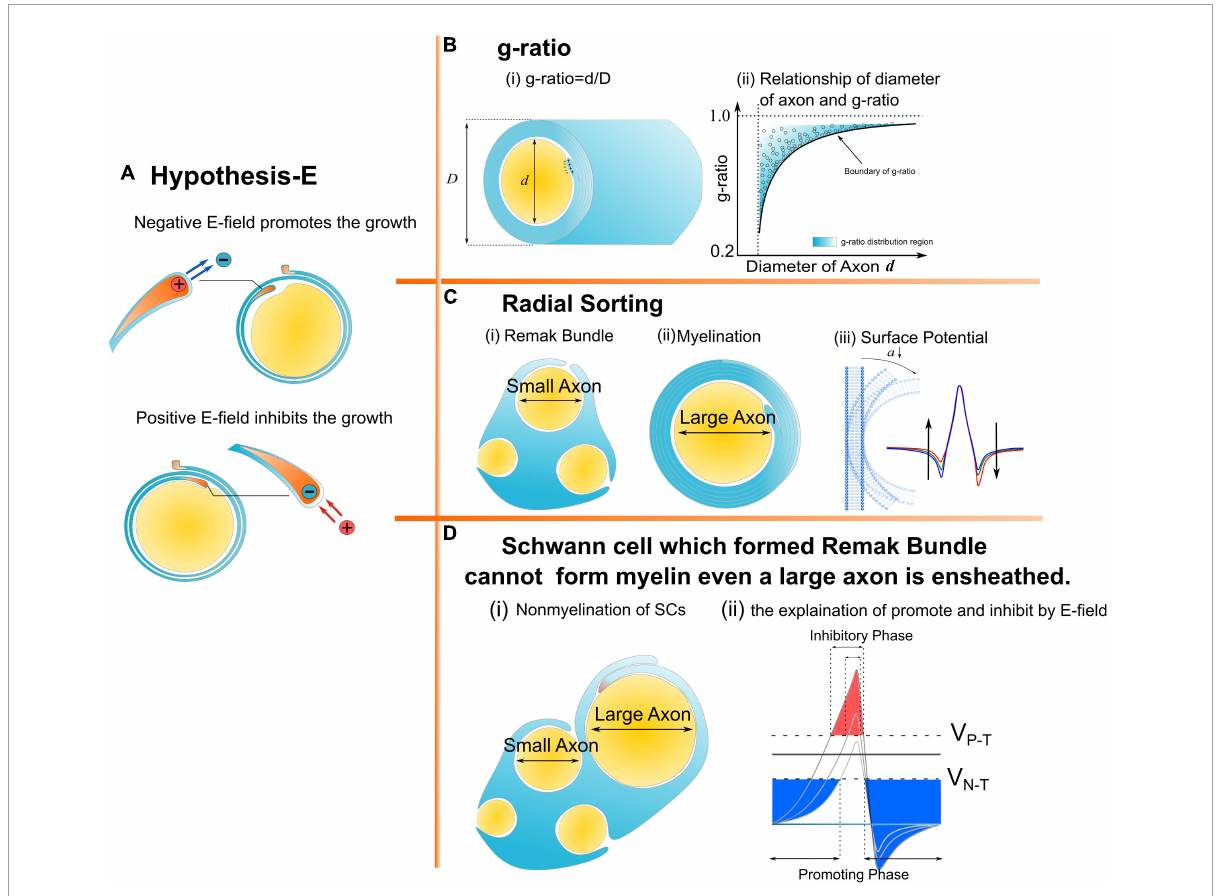
FIGURE1 A series of morphological characteristics of myelin explained a mathematical and physical perspective. (A) Hypothesis-E: The effect of E-field on myelin growth; (B,C) phenomena explained by Hypothesis-E: (B) g-ratio: The thickness of myelin sheath has a specific relationship with the diameter of the axon. (C) Radial Sorting: Myelin selectively myelinated axon based on axonal diameter; (D) SC of remak bundle cannot form myelin even when a large axon is ensheathed.